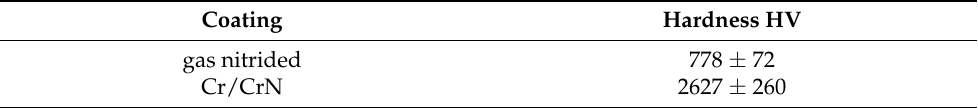
Table 3. The measurement results of hardness.